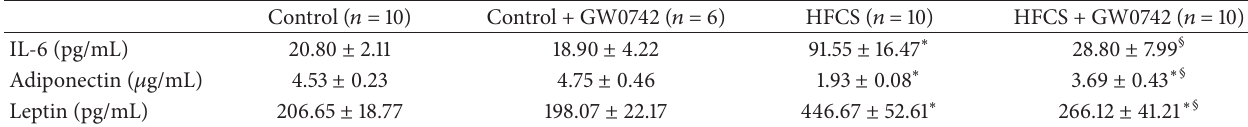
Table 1: Effects of chronic in vivo treatment with GW0742 on mouse blood parameters after 30 weeks of dietary manipulation.